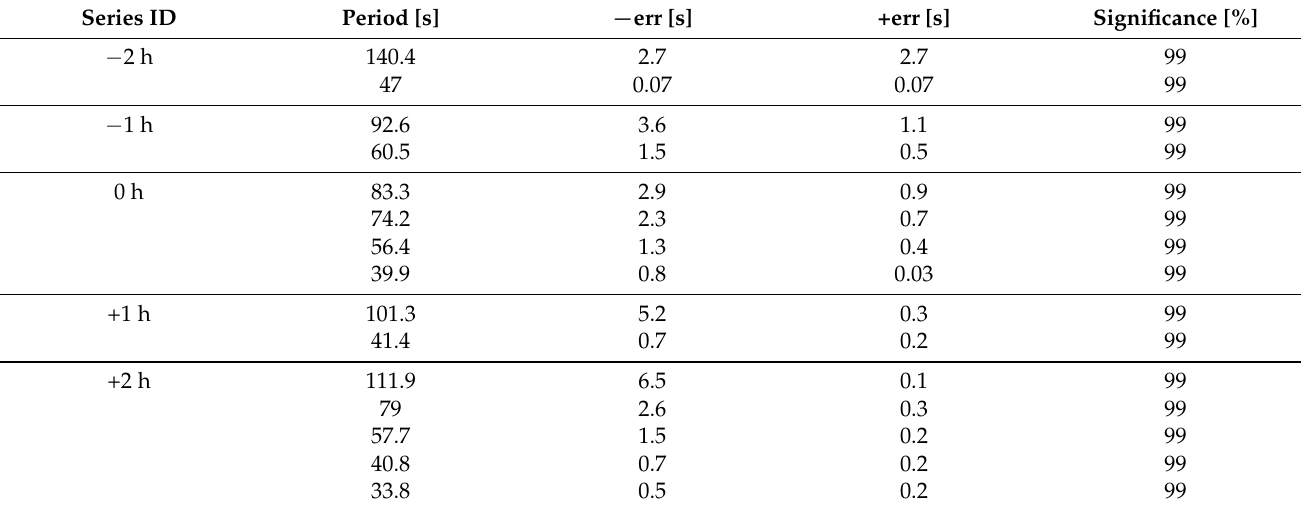
Table 2. Summary of detected periods in control case corresponding to the same date as earthquake occurrence but one year earlier. Periods are measured from integrated versions of 2D Hybrid maps (bottom marginal panels) in Figure 3. Columns: series part with respect to nominal earthquake beginning time, detected periods, lower and upper